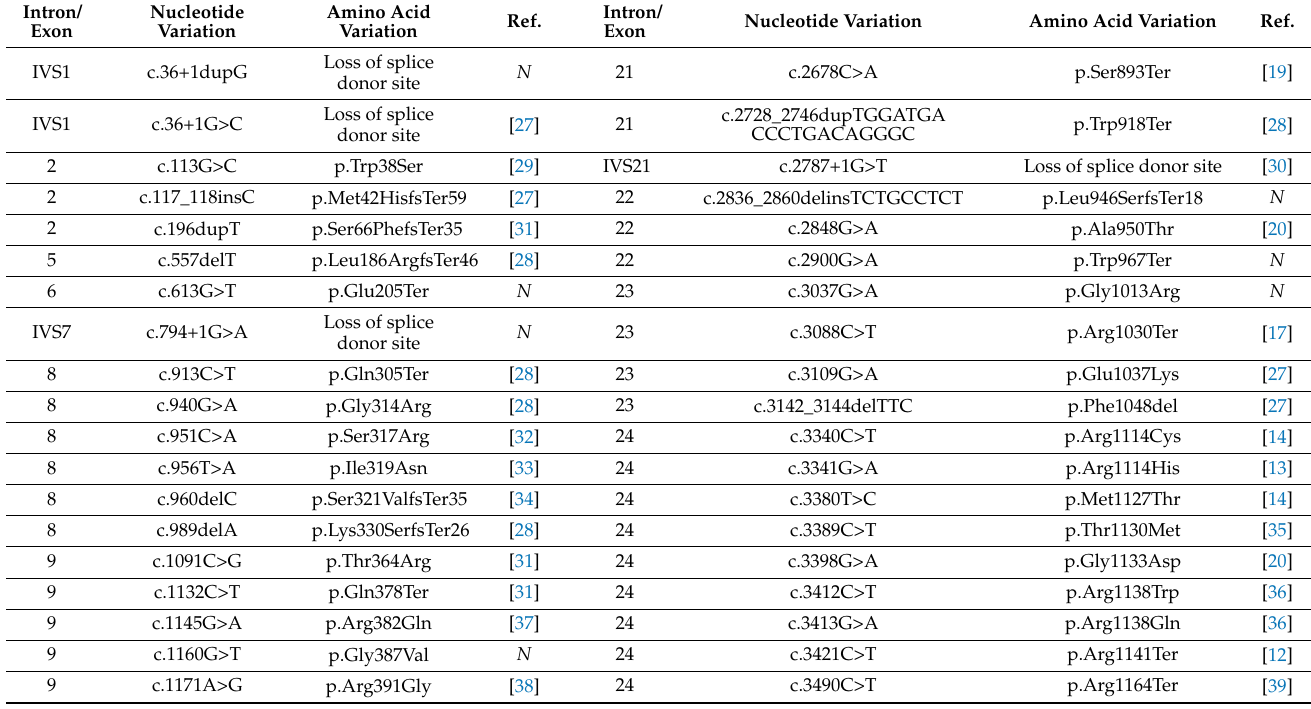
been already published, while the remaining 21 (18%) were reported in this study (Table 1 and Table S1). Table 1. Rare sequence variants found in Italian PXE patients. N = new rare sequence